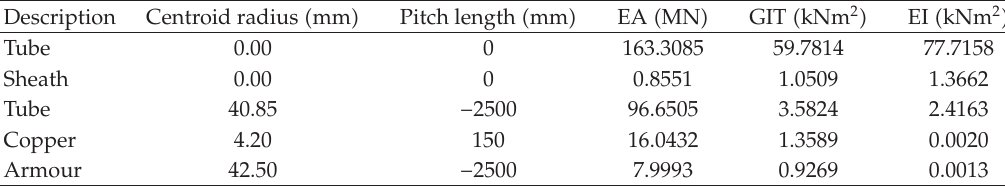
Table 6: Umbilical 3 parameters.